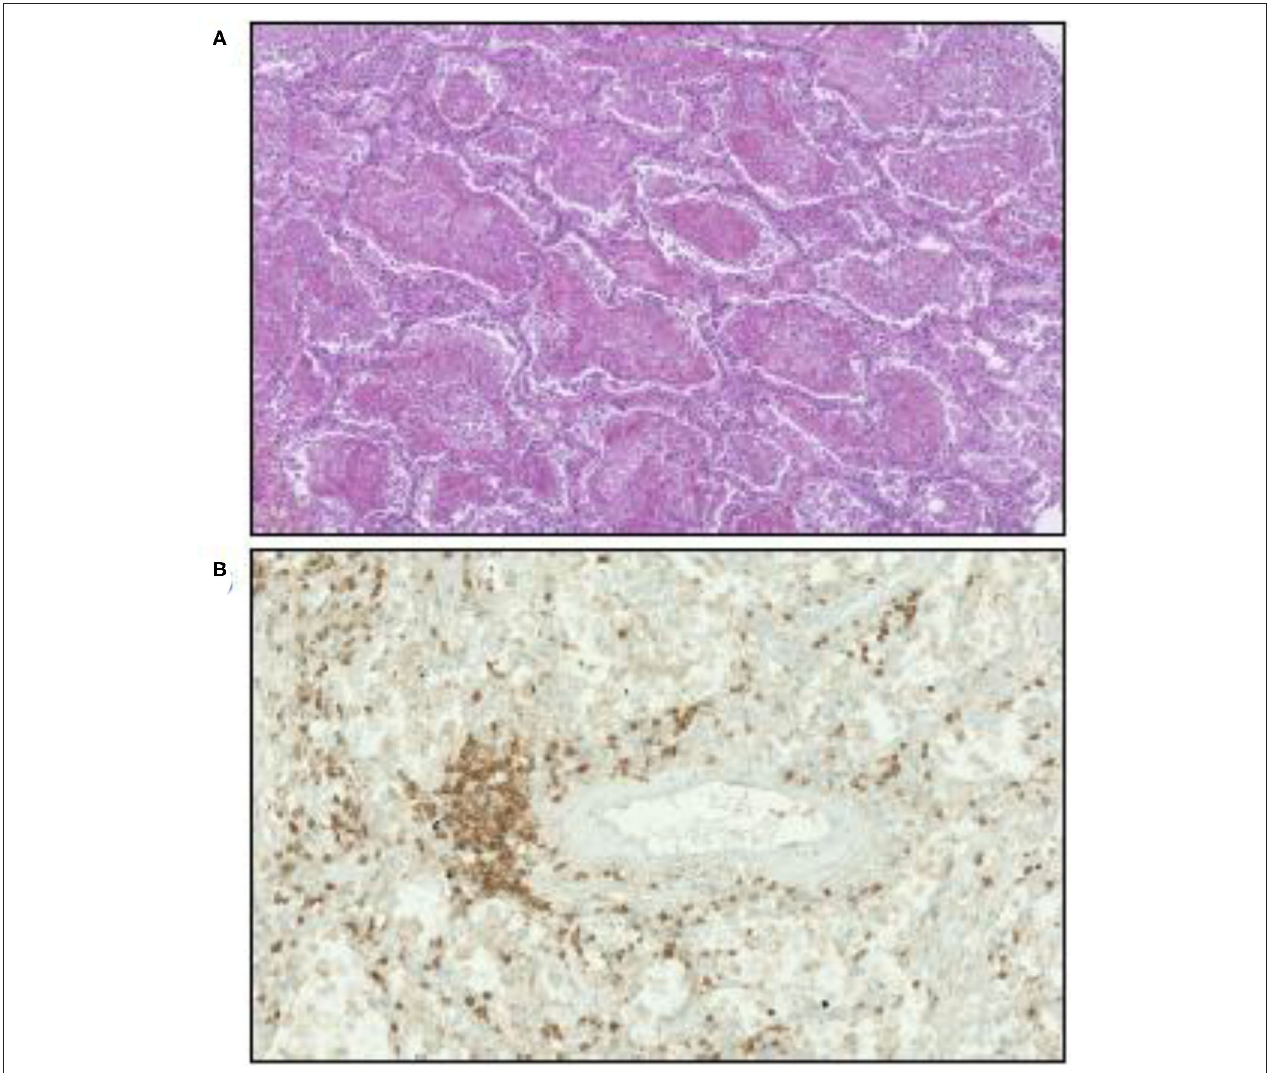
FIGURE 4 | Illustration of microscopic examination of tissues from patients who died of COVID-19 (postmortem formalin lung sample from medical autopsy performed in the forensic medicine department of Marseille Hospital). (A) Hematoxylin, eosin, and saffron staining showing intra-alveolar fibrin. Original magnification × 70. (B) Inflammatory perivascular lymphocytes T infiltration evidenced by anti-CD3 monoclonal antibody immunostaining. Original magnification ×